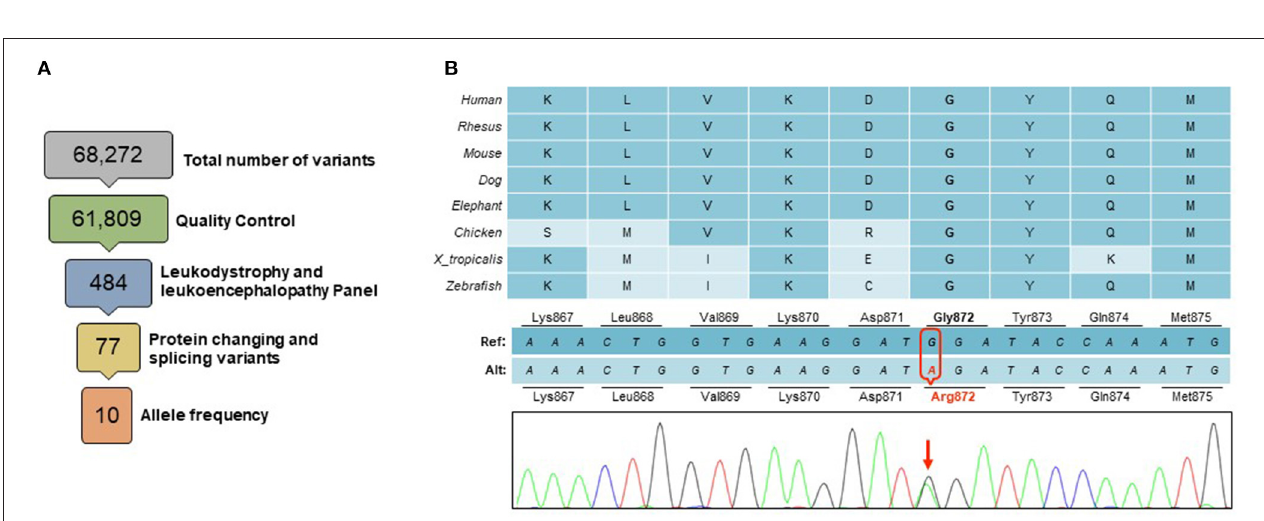
FIGURE 1 | Brain MRI findings. (A,B) Bilateral patchy and predominantly frontoparietal white matter hyperintensities with accompanying marked gray matter atrophy are observed on T2-weighted fluid-attenuated inversion recovery (FLAIR) imaging. Cavum septum pellucidum is also evident. (C) Thinning of the corpus callosum is observed on a T1-weighted sequence.